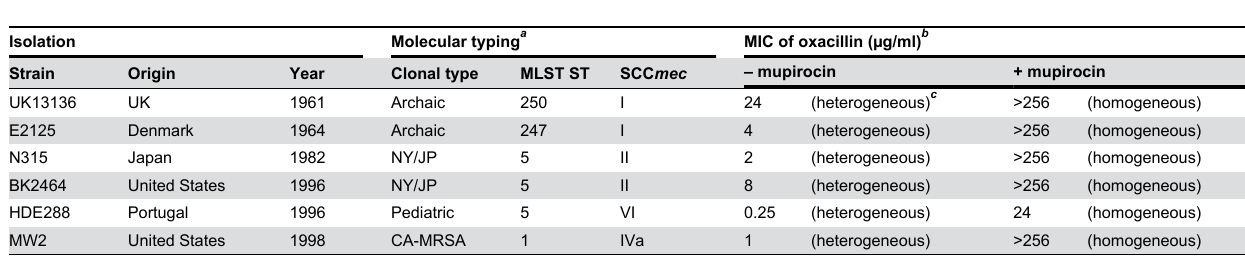
Table 2. Effect of mupirocin on the beta-lactam antibiotic resistant phenotype of clinical MRSA isolates.